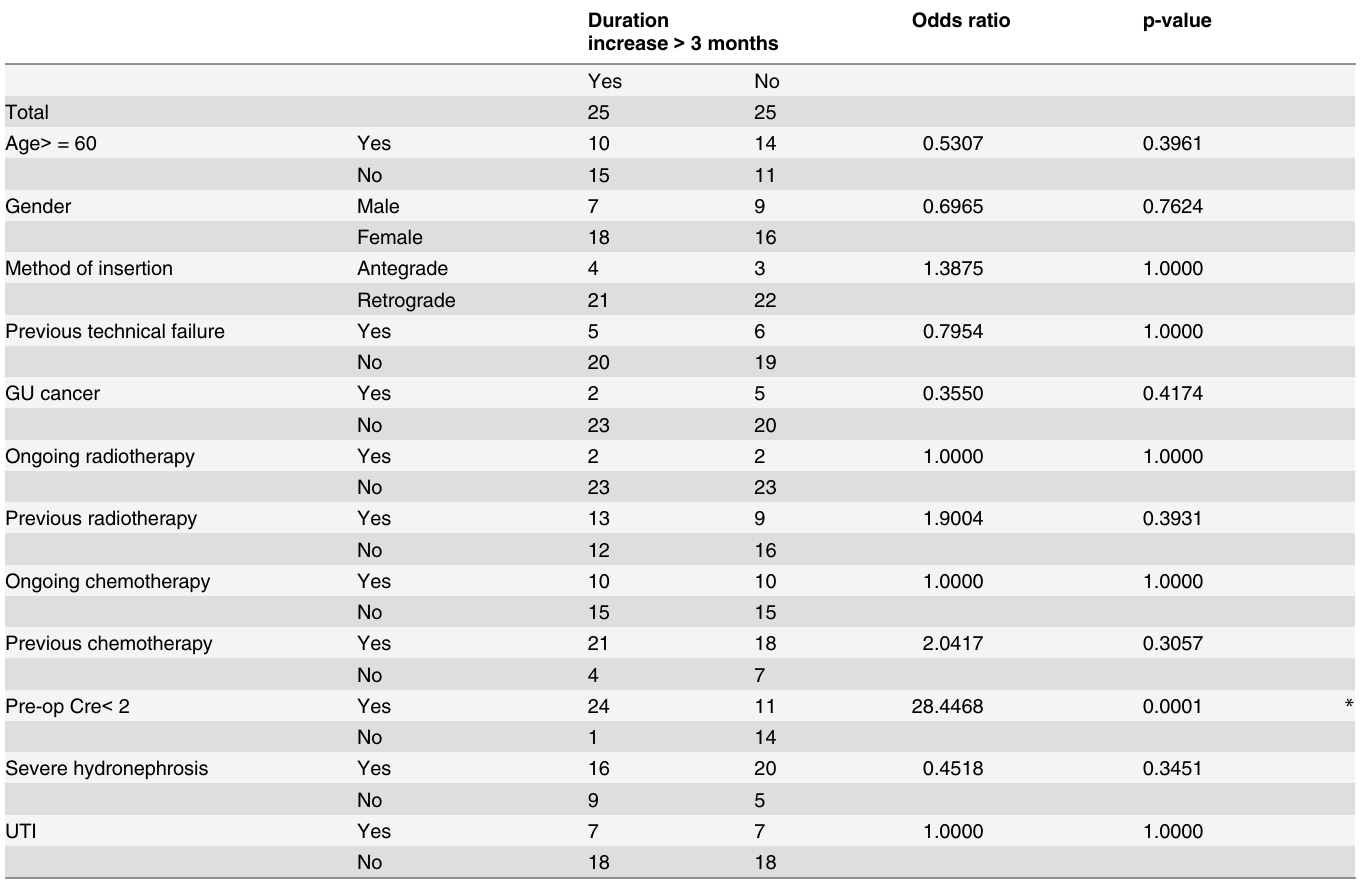
Table 3. The effects of clinical factors on the outcome of